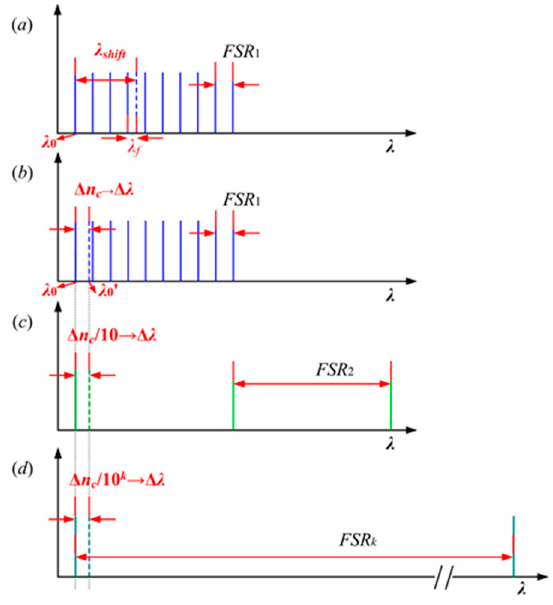
Figure 1. Illustration of the multi-scale measurement theory.